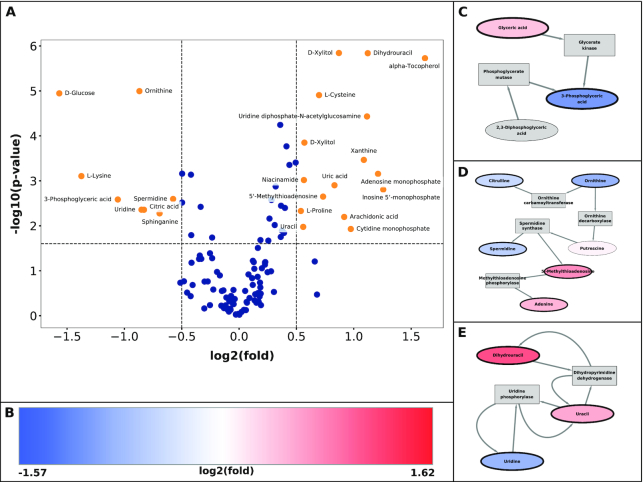
Integration and analysis of metabolomic measurements on metabolic networks, Study 1. Metabolomic Study 1 (Table S3) compared the abundances of 177 metabolites between cancerous and normal lung tissues. Clusters of enrichment in fold changes are detectable by integrating measurements within the non-compartmental network without hubs (Fig. 3D). A, Volcano plot of P-values and fold changes in metabolites. B, Scale for color representation of fold changes on nodes in clusters. Extremes of color scale represent the minimal and maximal fold changes in the entire study. C–E. Clusters in metabolic network are detectable by enrichment of P-values and fold changes. Metabolite nodes in clusters represent fold changes by color fill, and they represent P-value by border thickness (P-value < 0.05).